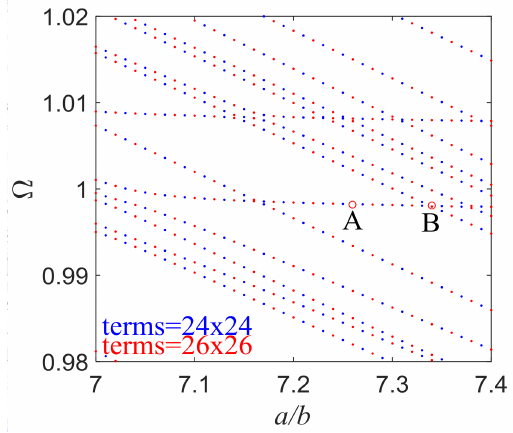
Figure 2. Frequency spectra of trapped-energy resonators when d / b = 15, R =